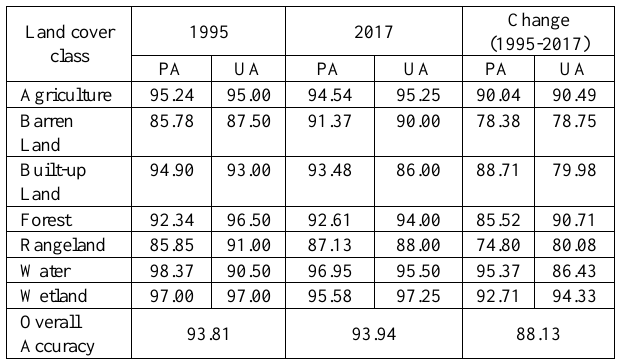
Table 3. Summary of Level 1 land cover classification and change detection accuracies (%) for 1995 and 2017. (PA: